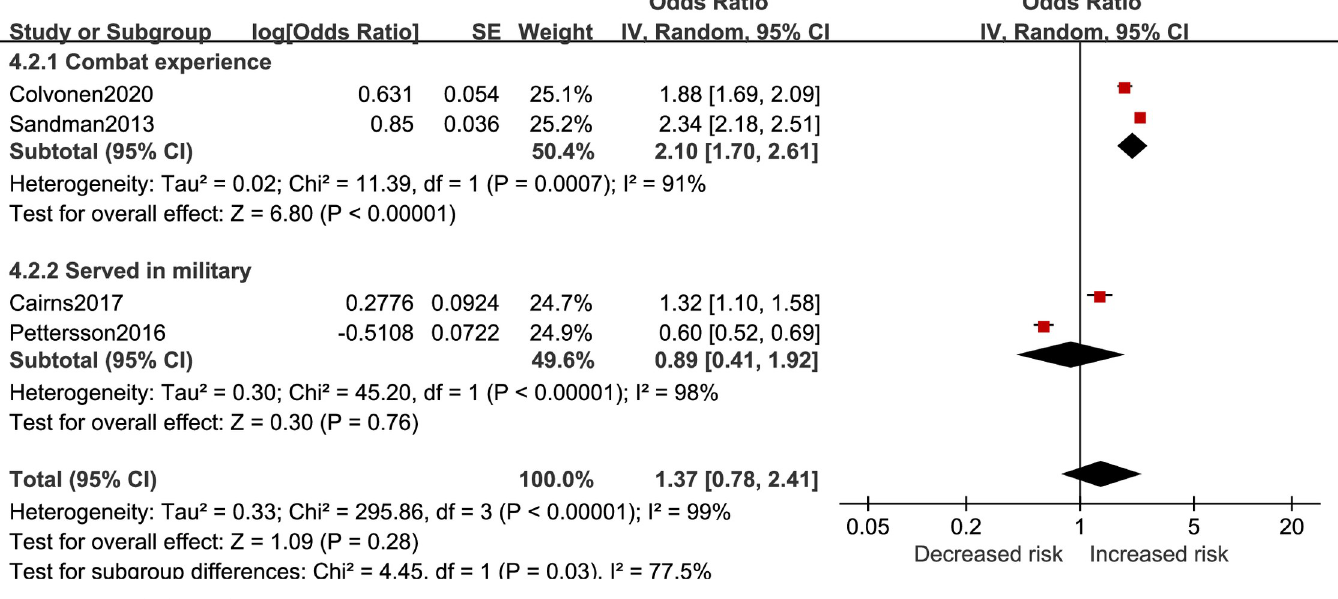
Fig 9. Army-specific factors for insomnia in veterans.